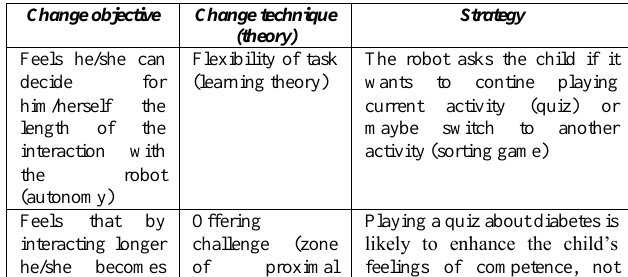
M APPING TECHNIQUES ON CHANGE OBJECTIVES AND DESCRIPTION OF STRATEGY OF